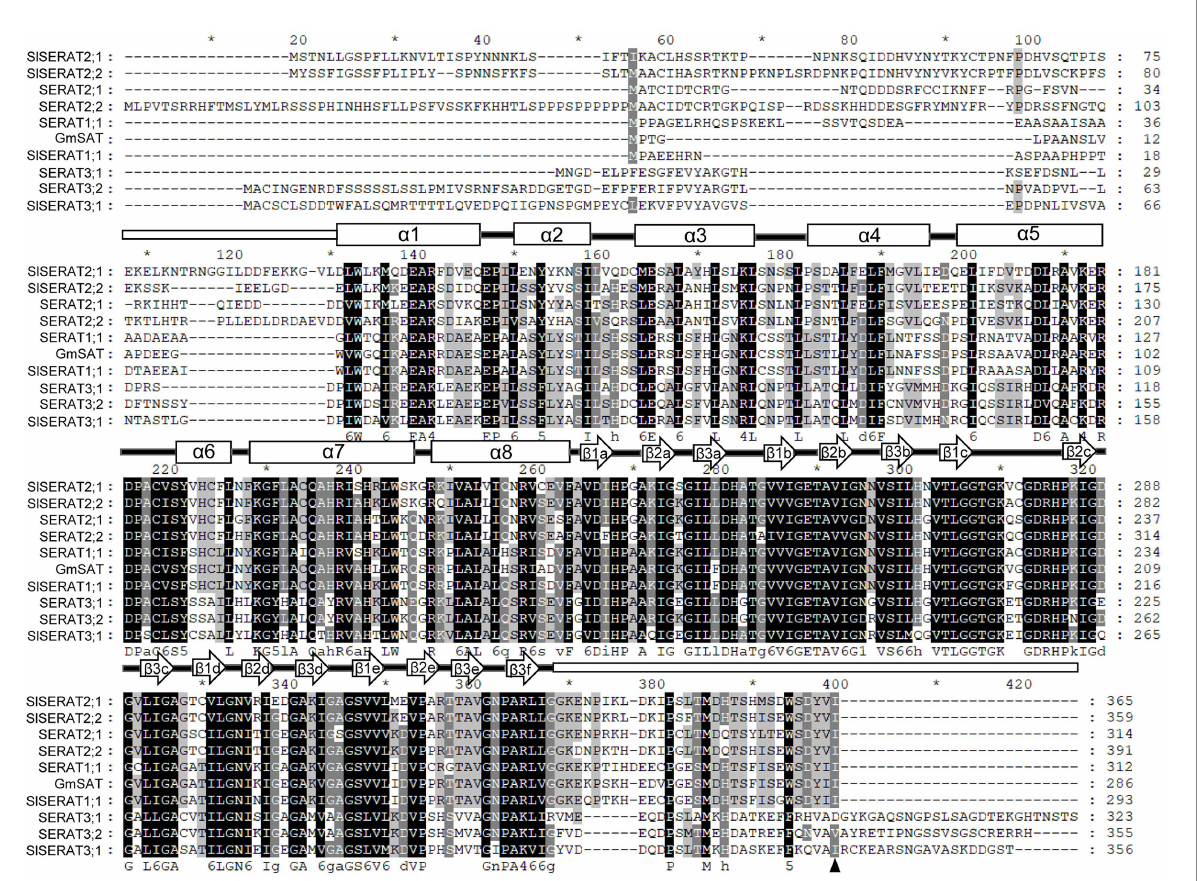
FIGURE 2 Comparison of the SERAT protein sequences from tomato, Arabidopsis and soybean. The secondary structures are shown above the sequences: white rectangles, α -helix; white arrows, β -sheets; and black bars, loops. The essential C-terminal Ile is indicated by a black triangle. White letters on a black background indicate the most conserved amino acids (identical in all the analyzed protein sequences), and the fading background color indicates a reduction in the